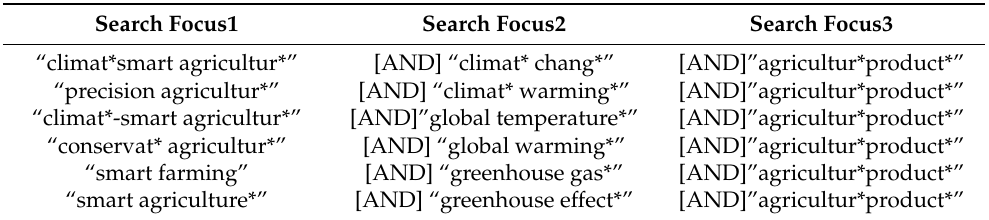
Table 2. Search focus